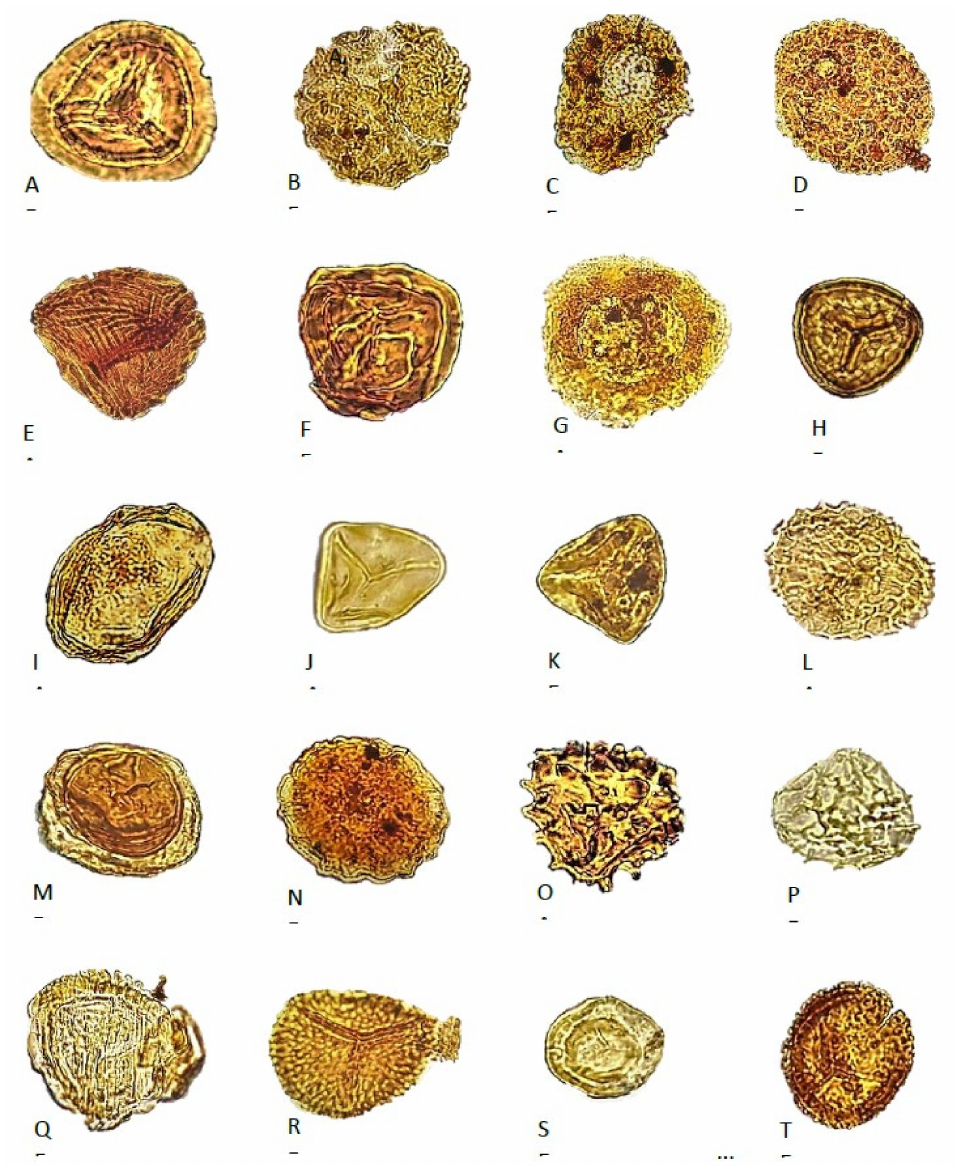
Figure 7. Terrestrial palynomorphs from boreholes Bh 1, Bh 3 and Bh 4. ( A ) Polycingulatisporites sp., Bh 1, 89.65 m (7), diameter 58 µ m. ( B ) Cerebropollenites macroverrucosus , Bh 3, 68.7 m (7), diameter 52 µ m. ( C ) Cerebropollenites macroverrucosus , Bh 4, 25.15 m (7), width 51 µ m. ( D ) Cerebropollenites thiergartii , Bh 4, 25.15 m (5), width 59 µ m. ( E ) Cicatricosisporites sp., Bh 4, 25.15 m (4), width 62 µ m. ( F ) Contignisporites problematicus , Bh 1, 8.8 m (7), width 60 µ m. ( G ) Densosporites sp., Bh 1, 116.87 m (3), width 65 µ m. ( H ) Camarozonosporites sp., Bh 1, 8.8 m (7), width 42 µ m. ( I ) Chasmatosporites apertus , Bh 1, 113.25 m (3), width 67 µ m. ( J ) Deltoidosporites toralis , Bh 3, 68.7 m (6), width 42 µ m. ( K ) Deltoidosporites sp., Bh 3, 16.6 m (5), width 40 µ m. ( L ) Lycopodiumsporites austroclavatidites , Bh 3, 99.1 m (7), width 56 µ m. ( M ) Perinopollenites elatoides , Bh 1, 22.23 m (7), width 54 µ m. ( N ) Callialasporites dampieri , Bh 3, 16.6 m (3), width 56 µ m. ( O ) Verrucosisporites ? sp., Bh 1, 89.65 m (7), width 60 µ m. ( P ) Lycopodiumsporites semimuris , Bh 3, 99.1 m (7), width 49 µ m. ( Q ) Striatella? sp., Bh 3, 31.6 m (7), width 62 µ m. ( R ) Apiculatisporites sp., Bh 3, 22.2 m (8), width 60 µ m. ( S ) Corollina sp., Bh 3, 22.2 m (8), width 32 µ m. ( T ) Sestrosporites sp., Bh 2, 200.5 m (7), width 50 µ